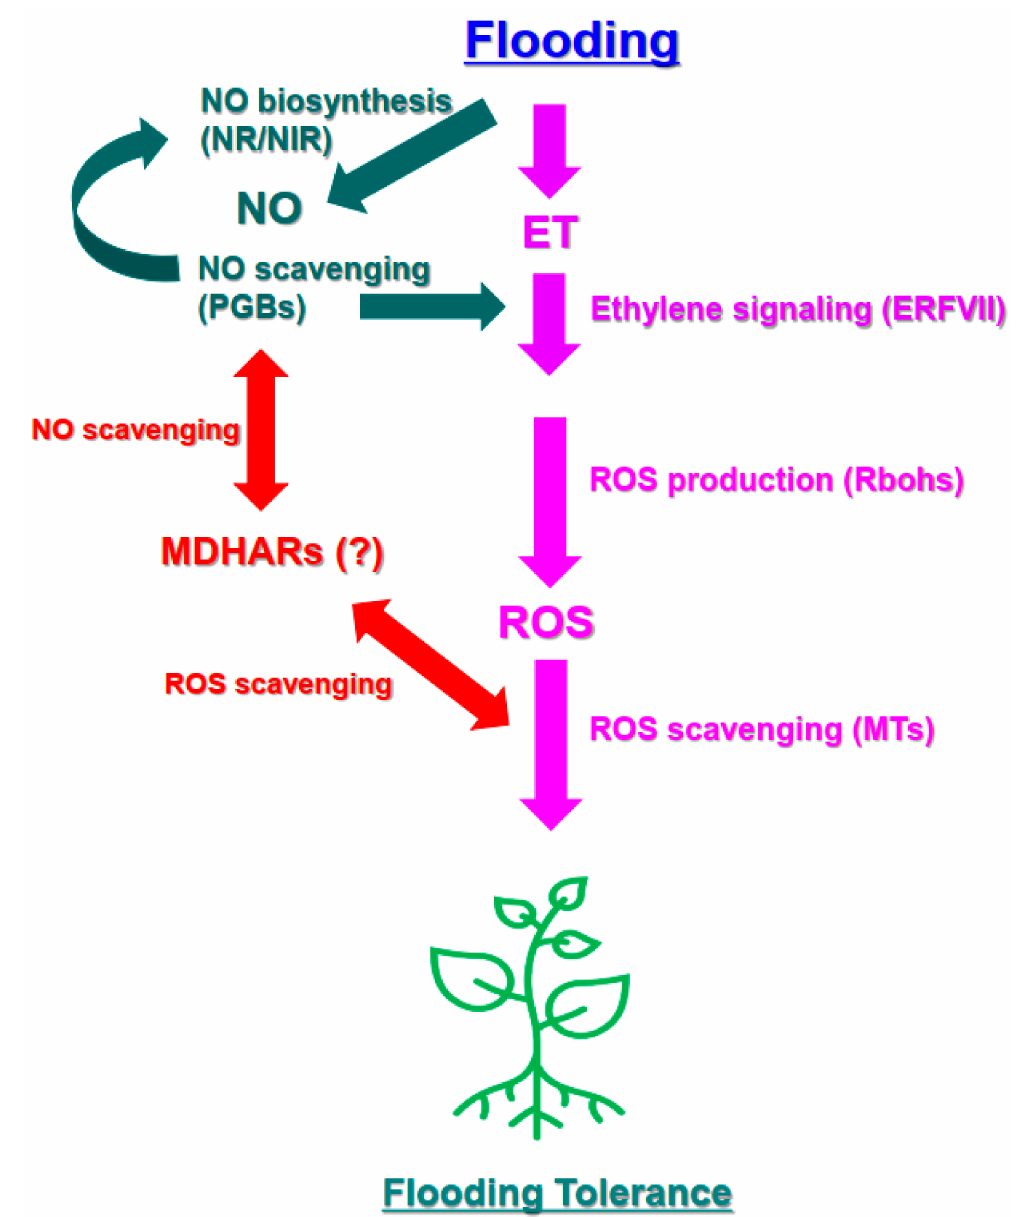
Figure 5. A suggested model of the ET-, ROS-, and NO-related biological processes and genes involved in influencing the flooding response that occurs in sweet potato leaves under early flood- ing. Flooding conditions result in the induction of ERFVII transcription factors and the expression of RBOHs, which produce O 2 − radicals from oxygen in the apoplast. RBOH expression may en- hance RBOH activity and increase ROS levels in the apoplast as well as the cytosol. Expression of genes encoding ROS scavengers, such as MTs, increases, leading to an increase in ROS signaling and scavenging responses and inducing the response in flooding-tolerant sweet potato. The NO synthesis-scavenging cycle regulates ERFVII-mediated signaling. MDHARs are also potentially involved in NO/ROS-mediated responses in sweet potato under early flooding conditions. ERF: ethylene response factor; ET: ethylene; ROS: reactive oxygen species; RBOH: respiratory burst oxidase homolog; MT: metallothionein; NO: nitric oxide; NR: nitrate reductase; NIR: nitrite reductase; PGB: phytoglobulin; MDHAR: monodehydroascorbate